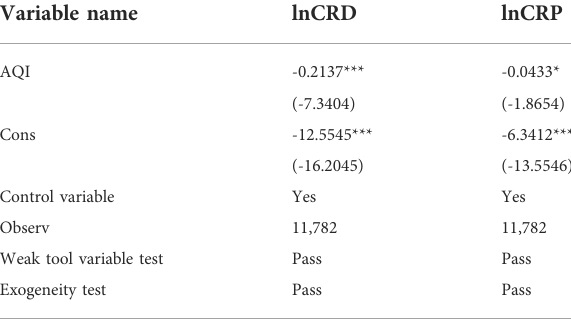
TABLE 14 Regression results of the instrumental variable method. Variable